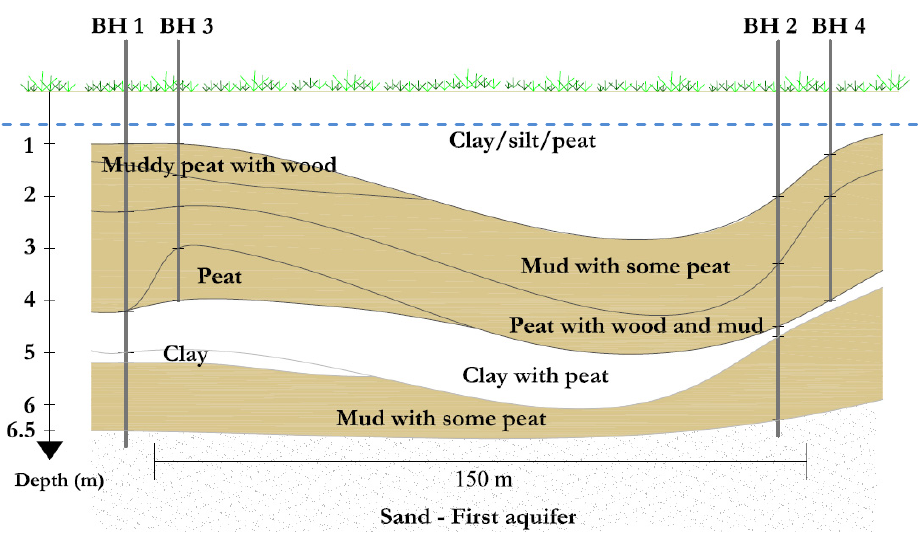
Fig. 5 Schematization of the CCL based on borehole descriptions. The average groundwater level for an average year is at about 40 cm below the ground level.